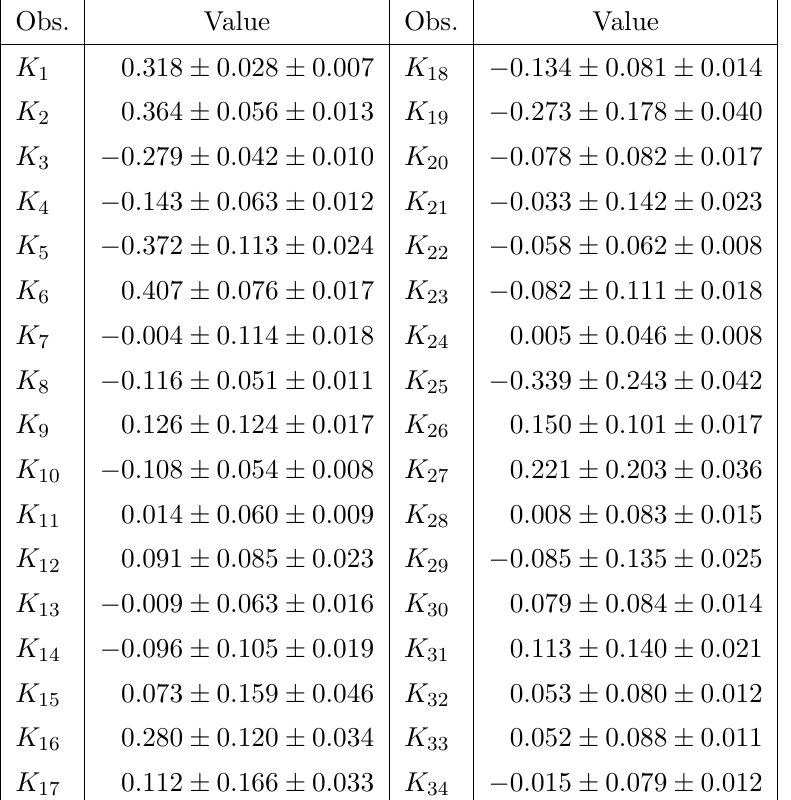
Table 4 . Measured values for the angular observables from the Run 2 data combining the results of the moments obtained from the candidates reconstructed in the long- and downstream-track p(cid:25) (cid:0) categories. The (cid:12)rst and second uncertainties are statistical and systematic,